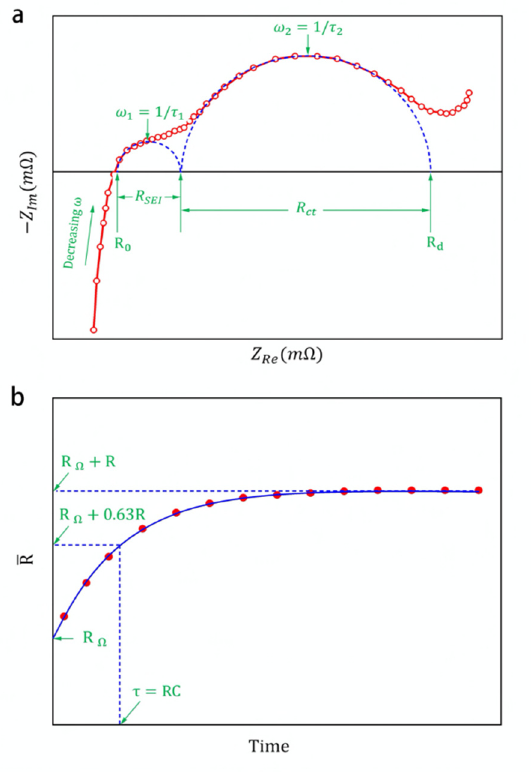
Figure 2. Schematic diagram of ( a ) Nyquist plot of EIS for a lithium-ion battery. ( b ) DCIS for one RC network.